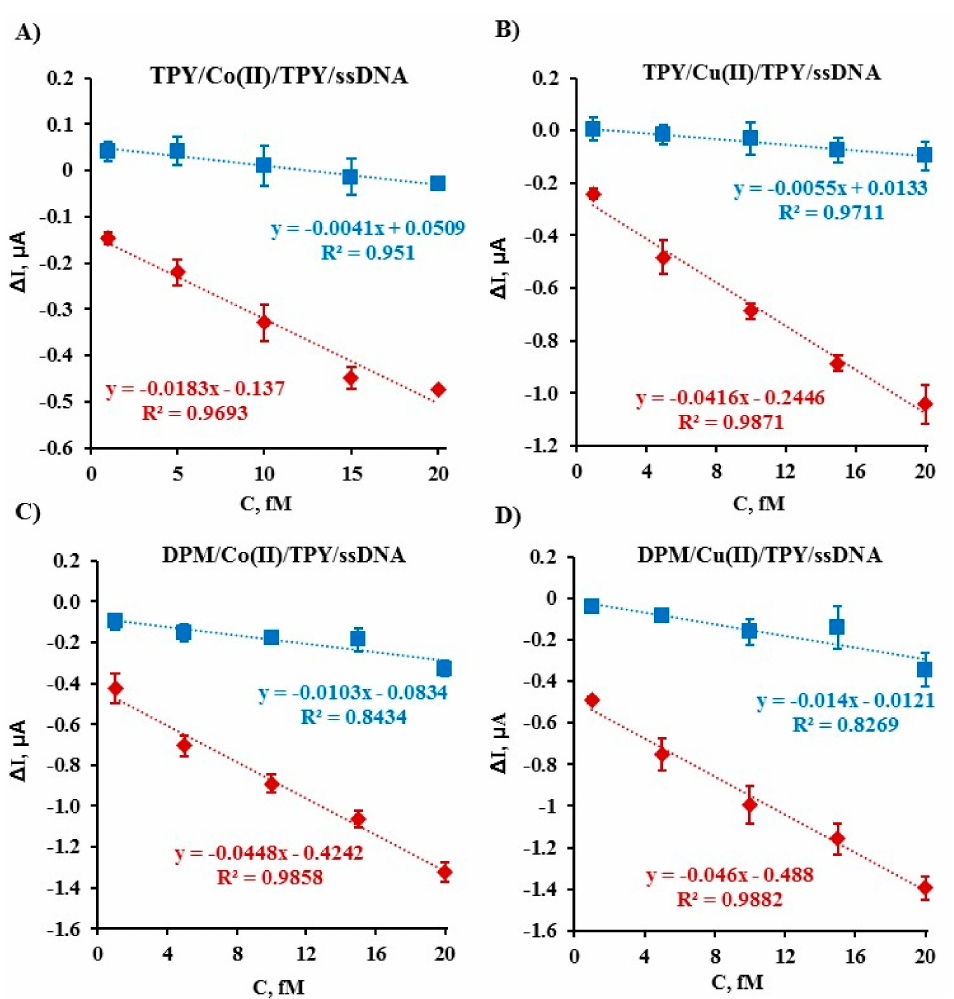
Figure 5. Relative intensity ∆ I = I n -I 0 [ µ A] of current in relation to ( (cid:7) ) concentration of 20-mer c-NC3 and ( (cid:4) ) concentration of 20-mer nc-NC3 for gold electrodes modified with: ( A ) TPY / Co(II) / TPY / ssDNA, ( B ) TPY / Cu(II) / TPY / ssDNA, ( C ) DPM / Co(II) / TPY / ssDNA and ( D ) DPM / Cu(II) / TPY / ssDNA redox-active